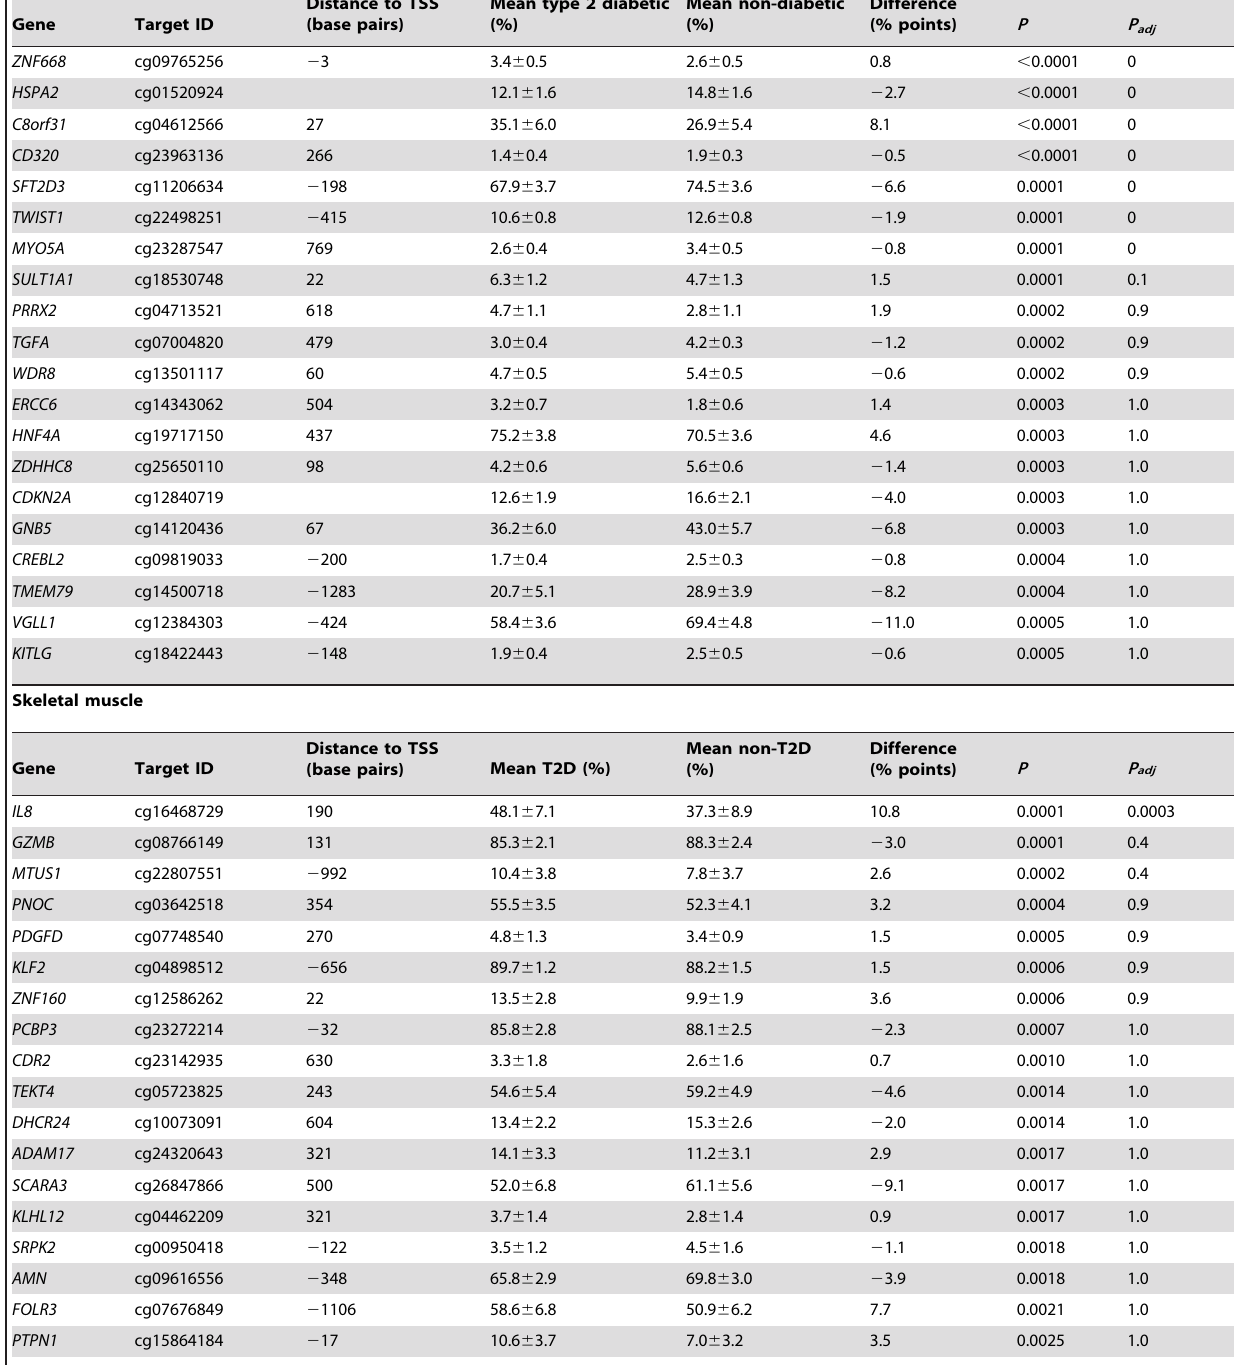
Table 3. Differentially methylated